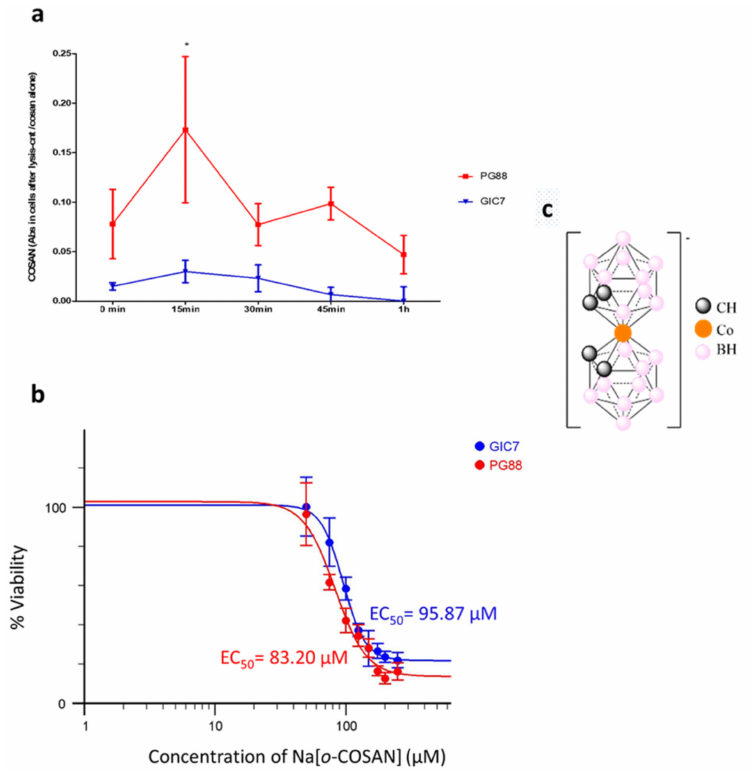
Figure 2. Kinetic of Na[ o -COSAN] uptake in glioma undifferentiated cells (GICs). Proneural (GIC7) and mesenchymal (PG88) GICs cultured on laminin-coated wells, 300,000 GICs/well, were seeded 24 h before treated with Na[ o -COSAN] (200 µ M). ( a ) Time course analysis of Na[ o -COSAN] uptake in lysed cells from GIC7 (blue) and PG88 (red) respective cultures are represented from Spectrometric Na[ o -COSAN] data analyzed (Synergy), plotted as the percentage of untreated cell cultures, mean ± SD, of three independent experiments. The uptake of the compound increased at 15 min of treatment on both GICs, being higher in PG88 concerning GIC7 (ANOVA, * p < 0.05). ( b ) Na[ o -COSAN] half-maximal effective concentration (EC 50 ) at 48 h in a doses-response curve, ranged 50 to 300 µ M. EC 50 of GIC7 (95.87 µ M) and PG88 (83.2 µ M) cells are not significantly different. ( c ) Schematic representation of the anionic small molecule cobaltabis (dicarbollide), [3,3 (cid:48) -Co(1,2-C 2 B 9 H 11 ) 2 ] − , abbreviated as [ o -COSAN] −